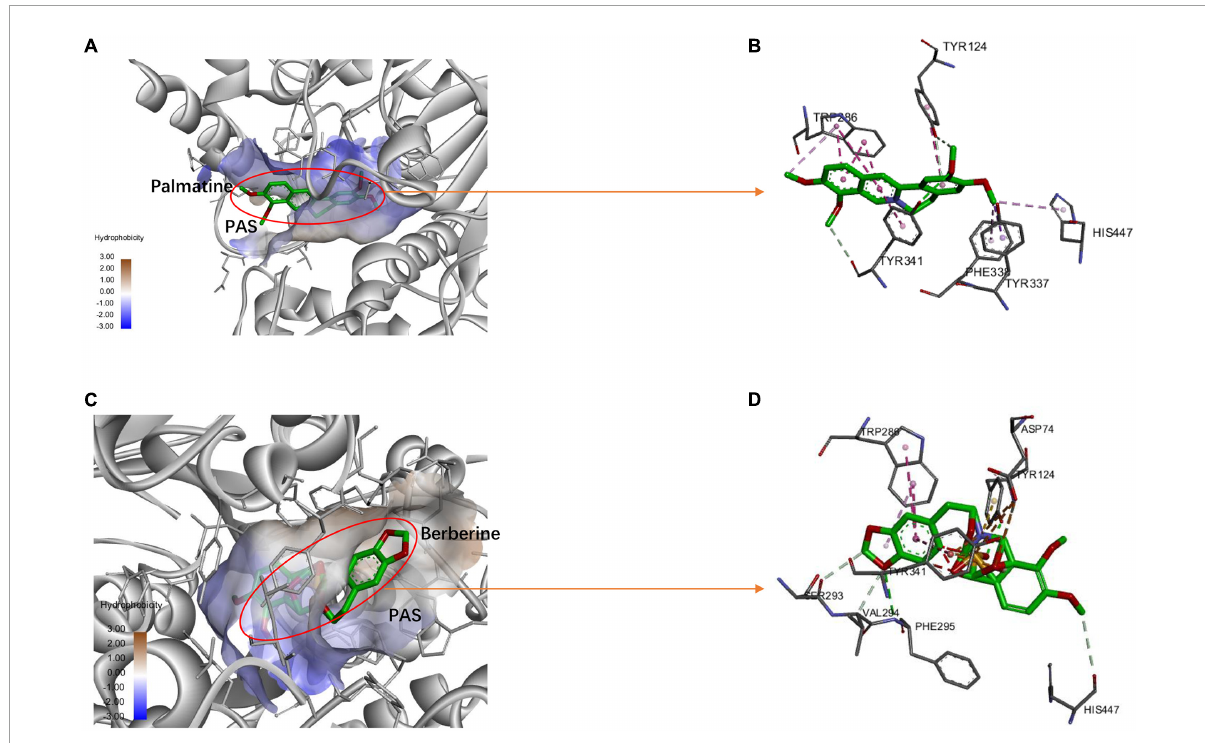
FIGURE13 The protein-ligand of the docking simulation: (A) Palmatine and 4EY7 (3D); (B) Palmatine and 4EY7 (2D); (C) Berberine and 4EY7 (3D); (D) Berberine and 4EY7 (2D).